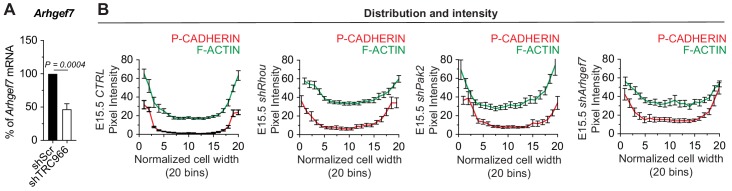
Similarities between RHOU, PAK2 and ARHGEF7 deficiency phenotypes in skin.(A) qPCR analyses in mouse keratinocytes validate shRNA mediated knockdown of Arhgef7. Error bars represent SEM from n = 8 experiments. Normal distribution of the data was tested using the Shapiro-Wilk test. Parametric paired two-tailed t-test was used to compare the data. (B) Pixel intensity measurements across the diameter of basal progenitors. Note the broader distribution of P-CADHERIN and the increase intensity of F-ACTIN in the cytoplasm of shRhou, shPak2 and shArhgef7-transduced cells.